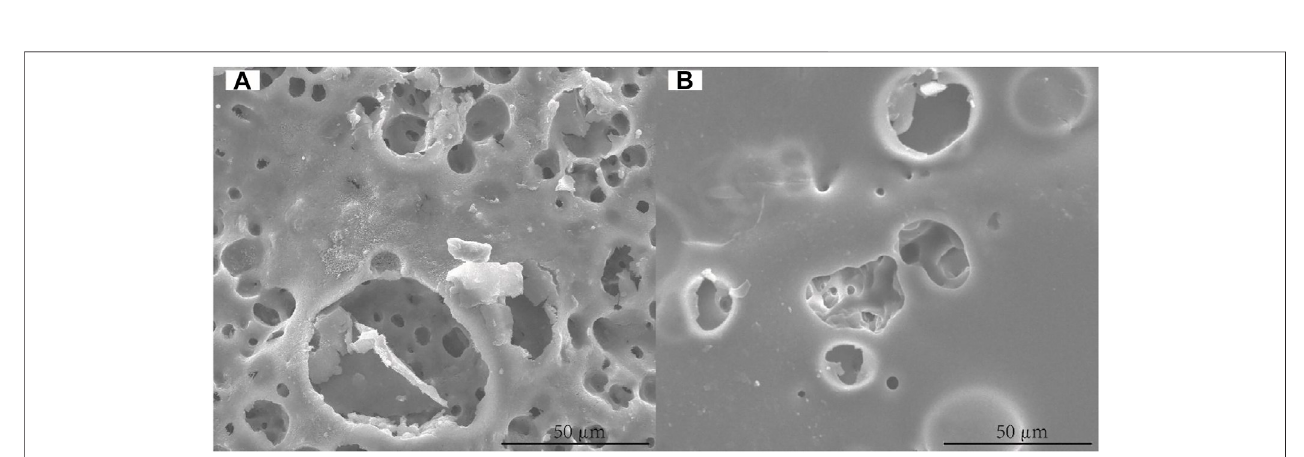
FIGURE 7 | The surface conditions of the propellant after being ignited. (A) Experiment 1. (B) Experiment 2.